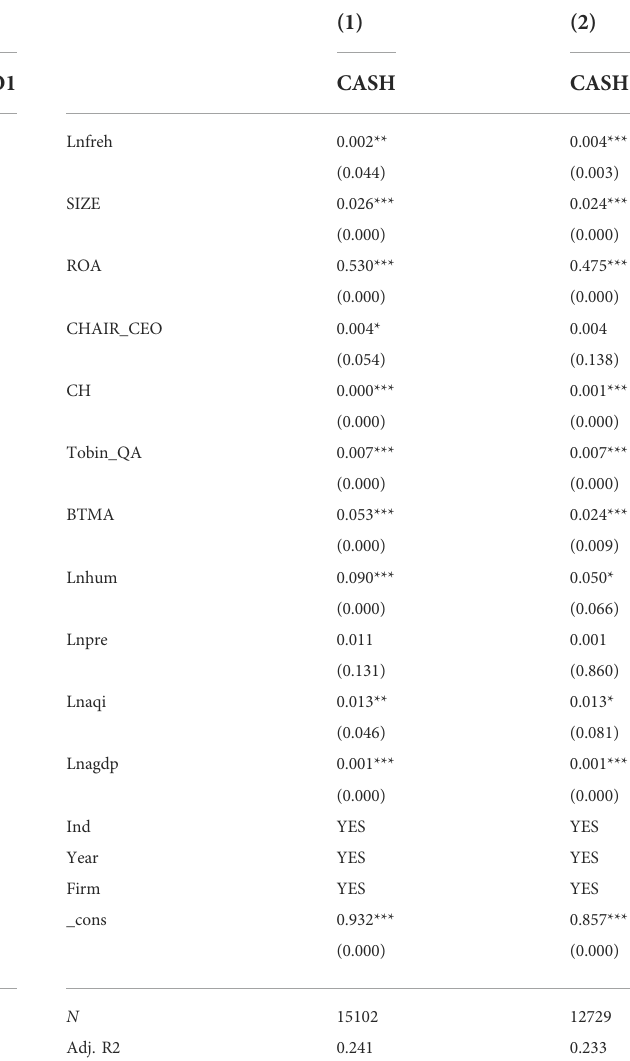
TABLE 5 Climate change and excess cash